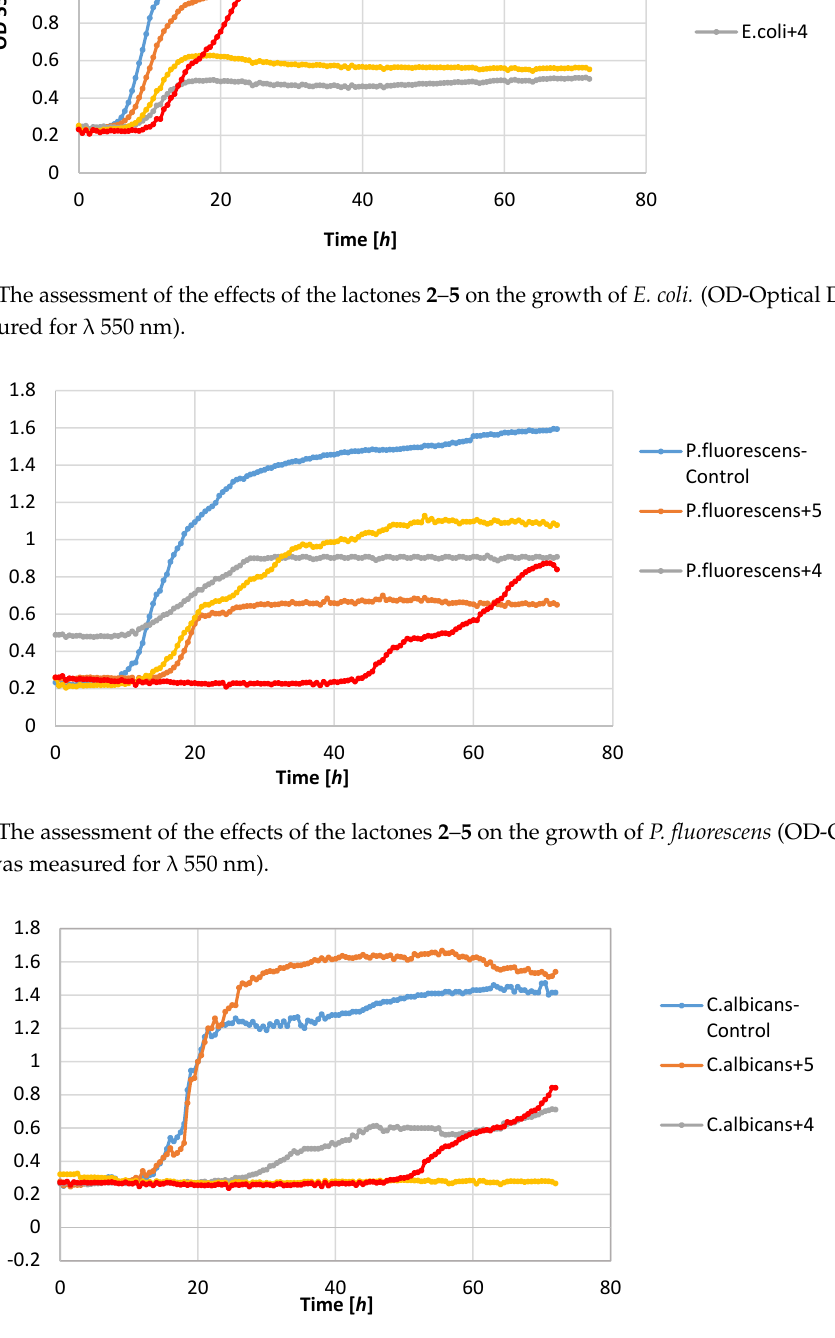
Figure 7. The assessment of the effects of the lactones 2 – 5 on the growth of C. albicans (OD-Optical Density was measured for λ 550 nm).